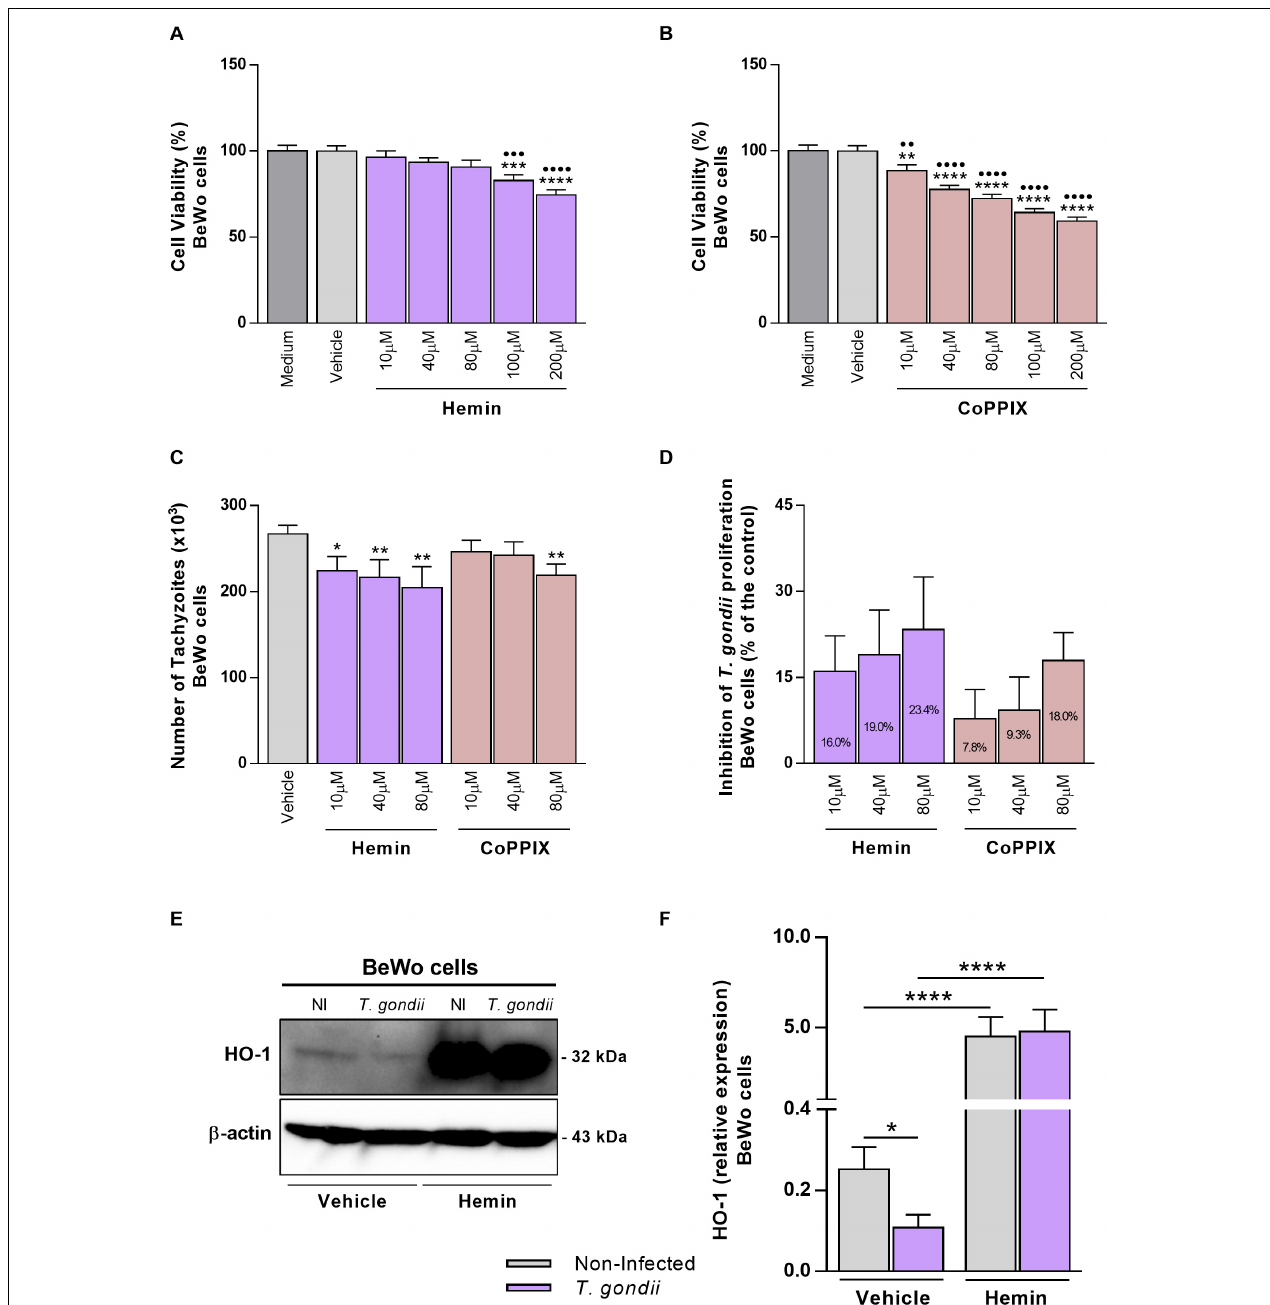
FIGURE 2 | Influence of HO-1 inducers on T. gondii proliferation and its expression by BeWo cells. (A,B) BeWo (3 × 10 4 cells/200 µ l/well) cells were cultured in 96-well plate during 24 h, treated with hemin or CoPPIX (10, 40, 80, 100, or 200 µ M) or incubated with vehicle (NaOH at 0.2%) or only medium (control) for additional 24 h, and submitted to MTT assay. The data were shown as the percentage of viable cells in relation to untreated cells (medium as 100% of viability). Statistical differences in relation to medium ( • ) or in relation to vehicle (*). (C) BeWo (3 × 10 4 cells/200 µ l/well) cells were cultured for 24 h, infected with T. gondii (1:1) for 3 h, treated with hemin or CoPPIX (10, 40, or 80 µ M), or incubated with vehicle (NaOH at 0.08%) as control during 24 h, and the T. gondii intracellular proliferation was analyzed by the β -galactosidase assay. The data were shown as number of tachyzoites ( × 10 3 ), used to calculate the inhibition of T. gondii proliferation (%) (D) . Statistical differences in relation to vehicle (*). (E,F) BeWo (1 × 10 6 cells/2,000 µ l/well) cells were cultured for 24 h, infected with T. gondii (1:1) or not, as the control of non-infected (NI) cells, for 3 h, treated with hemin (80 µ M) or not (NaOH at 0.08% as vehicle) during 24 h, and submitted to western blotting assays for detection of HO-1 and β -actin. The data were shown as representative blots and densitometric analysis for HO-1 relative expression. For all assays, the results were expressed as mean ± SEM from two or three independent experiments performed in six or eight replicates. Significant differences were statistically assessed by one-way ANOVA with Bonferroni’s posttest (A,B) , by Kruskal-Wallis with Dunn’s posttest (C) , or by Mann-Whitney test (F) . ∗ P < 0.05; ••∗∗ P < 0.01; •••∗∗∗ P < 0.001; ••••∗∗∗∗ P < 0.0001.